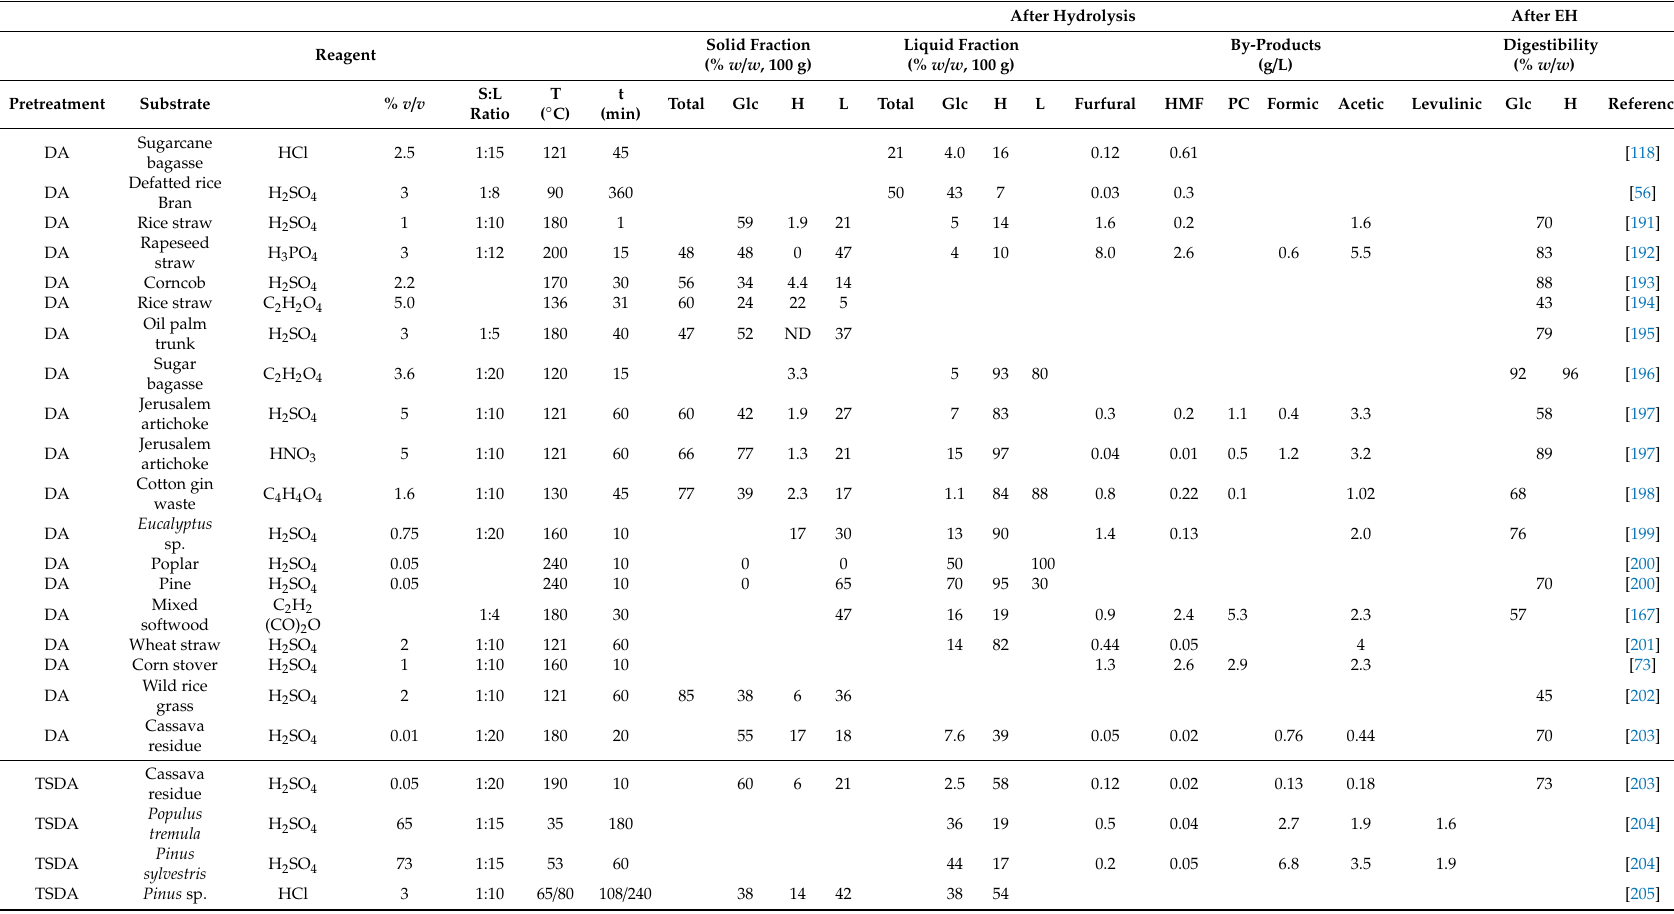
Table 1. Glucose (Glc), hemicelluloses (H), lignin (L) and inhibitory by-products produced after pretreatments of various lignocellulosic biomasses, as well as biomass digestibility (expressed as Glc and H released) after enzymatic